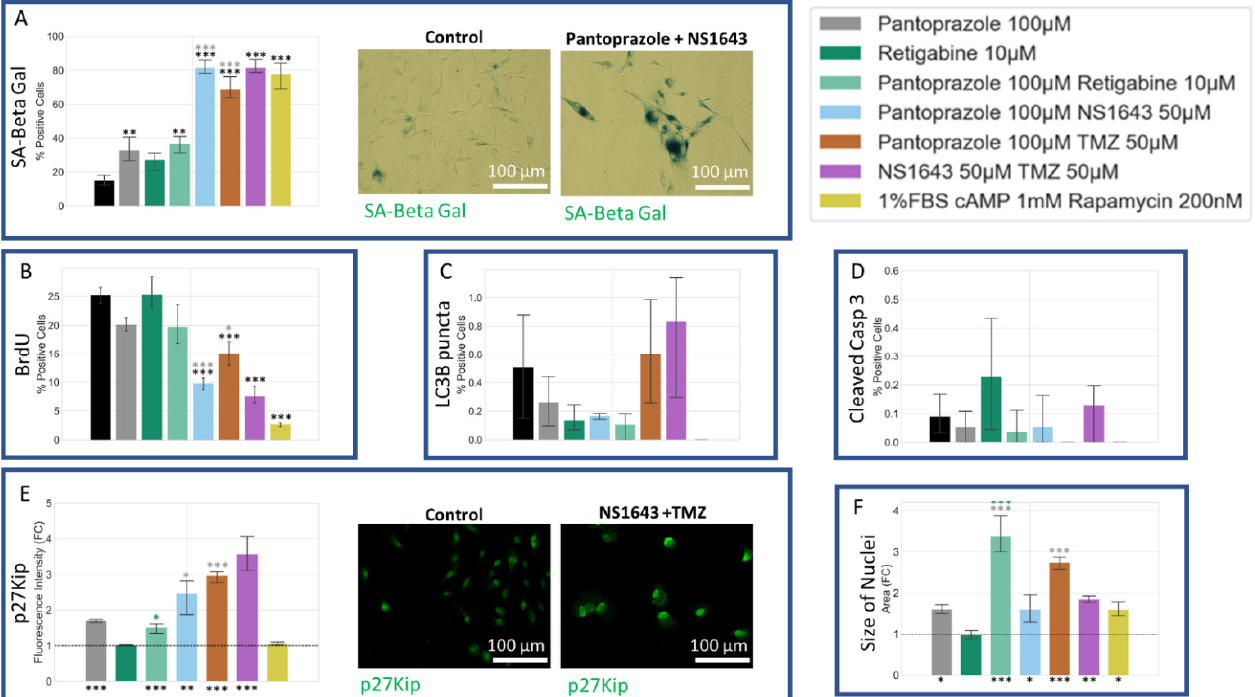
Figure 14. Senescence and Proliferation Analysis of U87 Cells Reveals that Treatments with Panto- prazole or NS164 with TMZ Increased Senescence, Decreased BrdU Incorporation, and Increased a p27 Kip1 after 6 days A senescence associated beta-galactosidase stain was conducted and scored by eye. Immunofluorescence of cells was conducted and analyzed with CellProfiler for integrated flu- orescence intensity or presence or absence of a cellular signal. ( A ) Stain of senescence associated beta-galactosidase stain (SA-Beta Gal). ( B ) Stain of bromodeoxyuridine incorporation (BrdU). ( C ) Stain of the microtubule-associated protein light chain 3 B (LC3B). ( D ) Stain of cleaved caspase 3 (Casp 3). ( E ) Stain of cyclin-dependent kinase inhibitor 1B (p27Kip). ( F ) Size of Nuclei, determined by area of the Hoechst stain. Treatments corresponding to the colored bars are outlined in the figure itself. The log of the fold change in intensity was compared between single treatments and combined treatments, except the positive control, with significant values shown in the color of the treatment compared. The initial fluorescence intensities were compared to their corresponding control, with significant values shown under the bars. The logit of the percent positive cells was compared be- tween single treatments and control, in cases of 0 values, the arcsine transformation was used. Sig- nificance was expressed as, ***: p < 0.001, **: p < 0.01, * : p < 0.05 (one-way ANOVA with Tukey post hoc analysis n > 3 technical replicates).